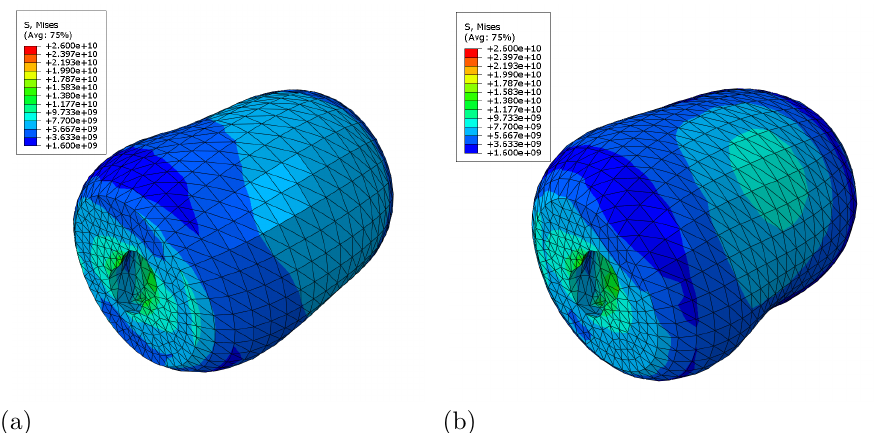
Figure 7. Visualization of von Mises stresses in the rotating initial geometry ( a ) and rotating optimized geometry ( b ).